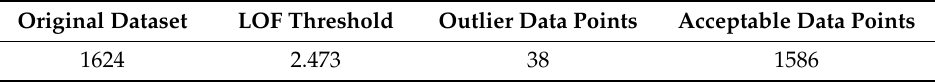
Figure 5. Collected dataset: ( a ) Local outlier factor (LOF) score, and ( b ) identified outliers in terms of defined RSS parameters. Table 5. Optimal local outlier factor (LOF) outlier